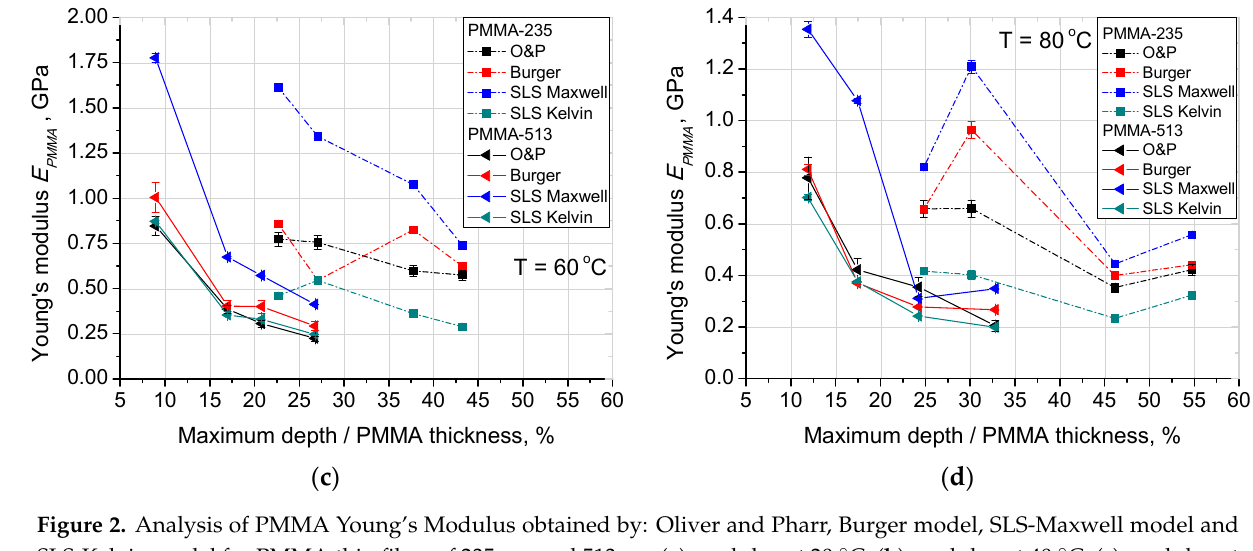
Figure 2. Analysis of PMMA Young’s Modulus obtained by: Oliver and Pharr, Burger model, SLS-Maxwell model and SLS-Kelvin model for PMMA thin films of 235 nm and 513 nm ( a ) modulus at 20 °C; ( b ) modulus at 40 °C; ( c ) modulus at 60 °C, ( d ) modulus at 80 °C. Lines are just guides for the eyes.